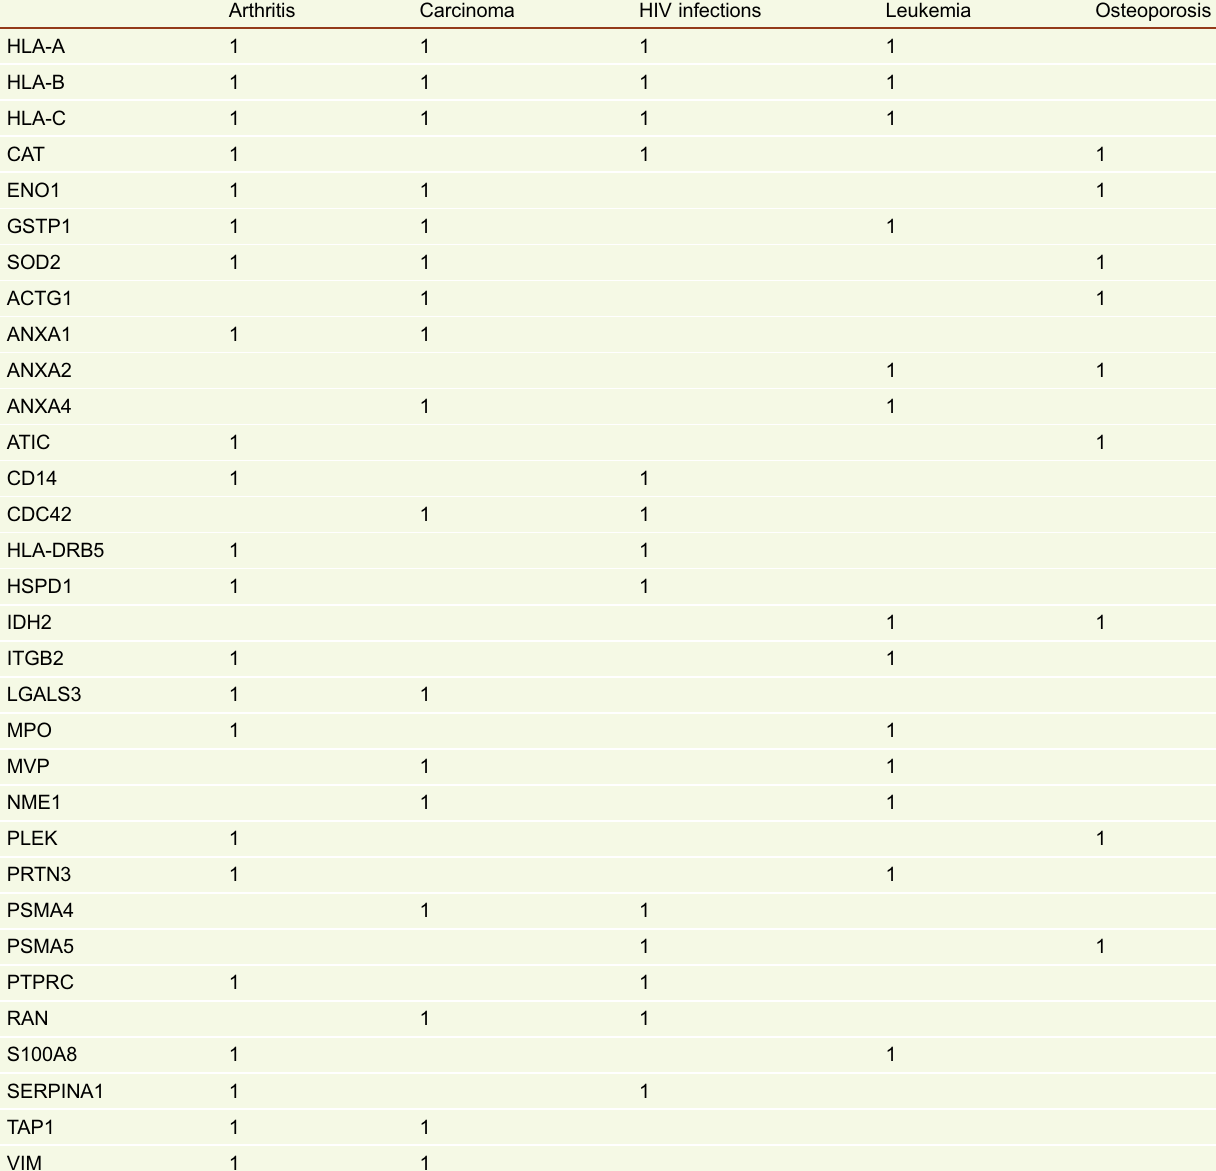
Table 3. Five representative diseases and the involved genes related to monocytes